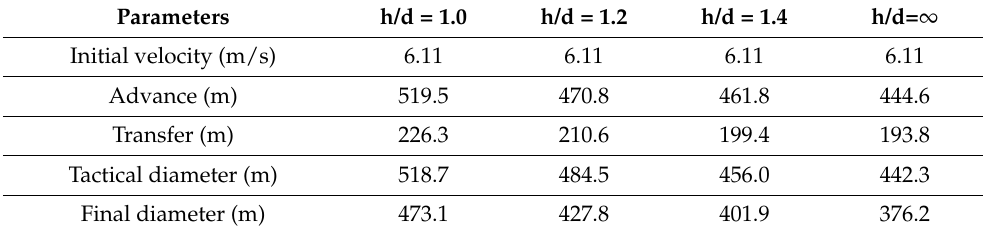
Figure 6. Turning test trajectory. Table 3. Turning test results.